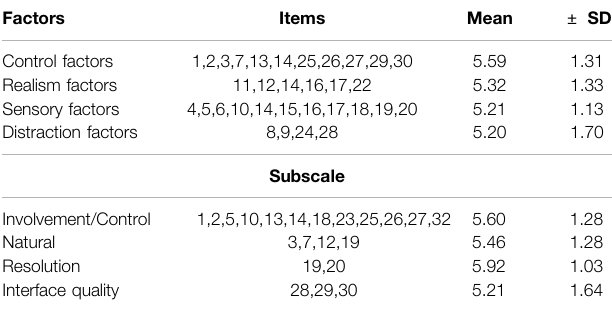
TABLE 3 | Mean values and standard deviations of different factors and